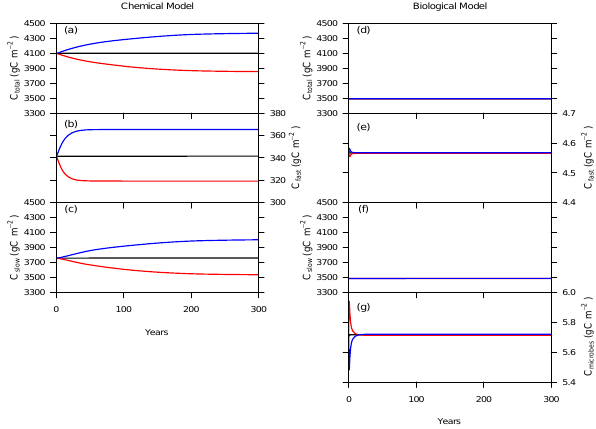
Figure 6. Soil carbon stocks of the chemical and biological models for the temperature change experiments. (a) is the total soil carbon ( C total , gCm − 2 ), (b) fast pool ( C fast , gCm − 2 ) and (c) slow pool ( C slow , gCm − 2 ) of the chemical model, (d) is the total soil car- bon ( C total , gCm − 2 ), (e) fast pool ( C fast , gCm − 2 ), (f) slow pool ( C slow , gCm − 2 ) and (g) microbial biomass ( C microbes , gCm − 2 ) of the biological model. Black line shows the nominal run, red line the warming and blue the cooling scenario. Only the first 300 years of the simulation are